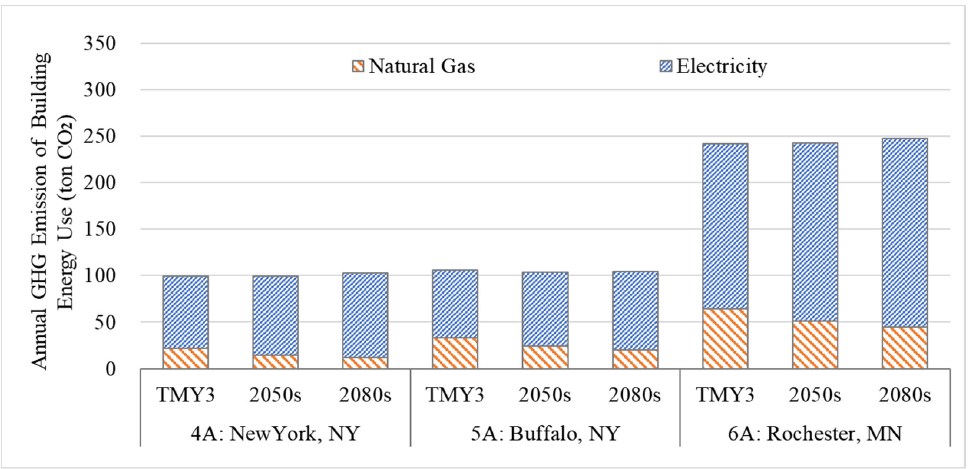
Figure 12. Annual embodied greenhouse gas (GHG) emission of baseline models by energy source type.